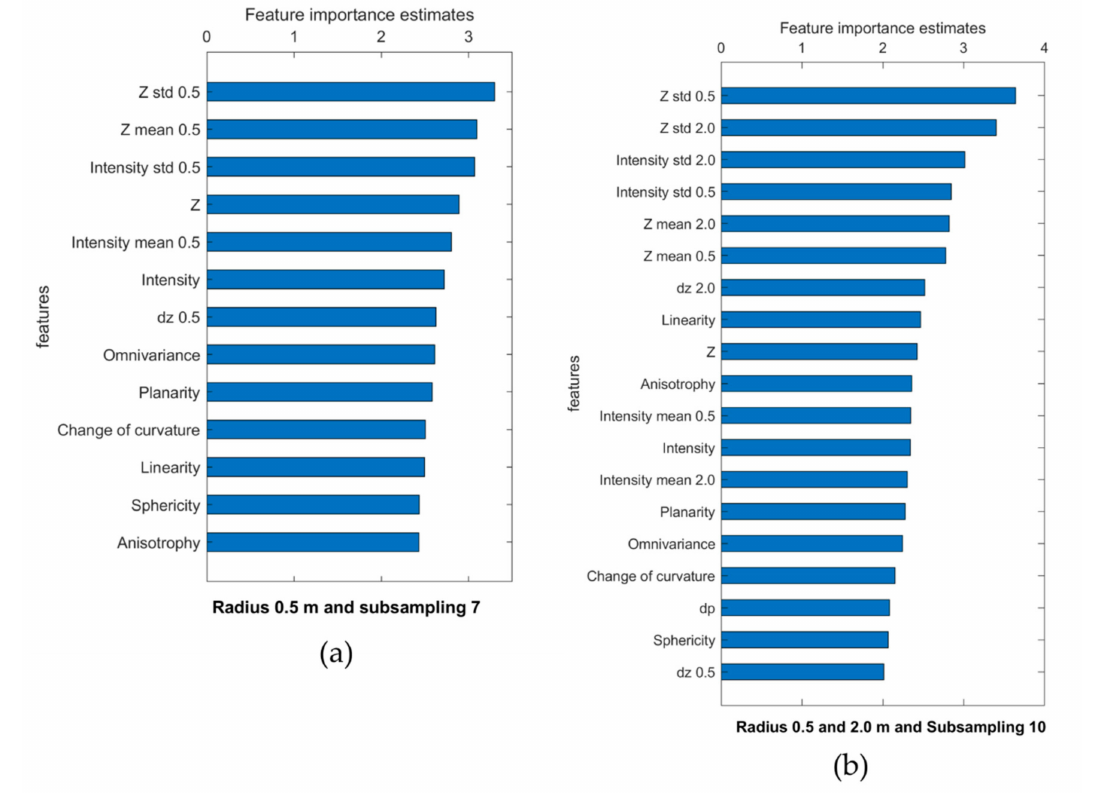
Figure 10. Estimates of feature importance for ( a ) radius 0.5 m with subsampling 7, and for ( b ) radius 0.5 m and 2 m with subsampling